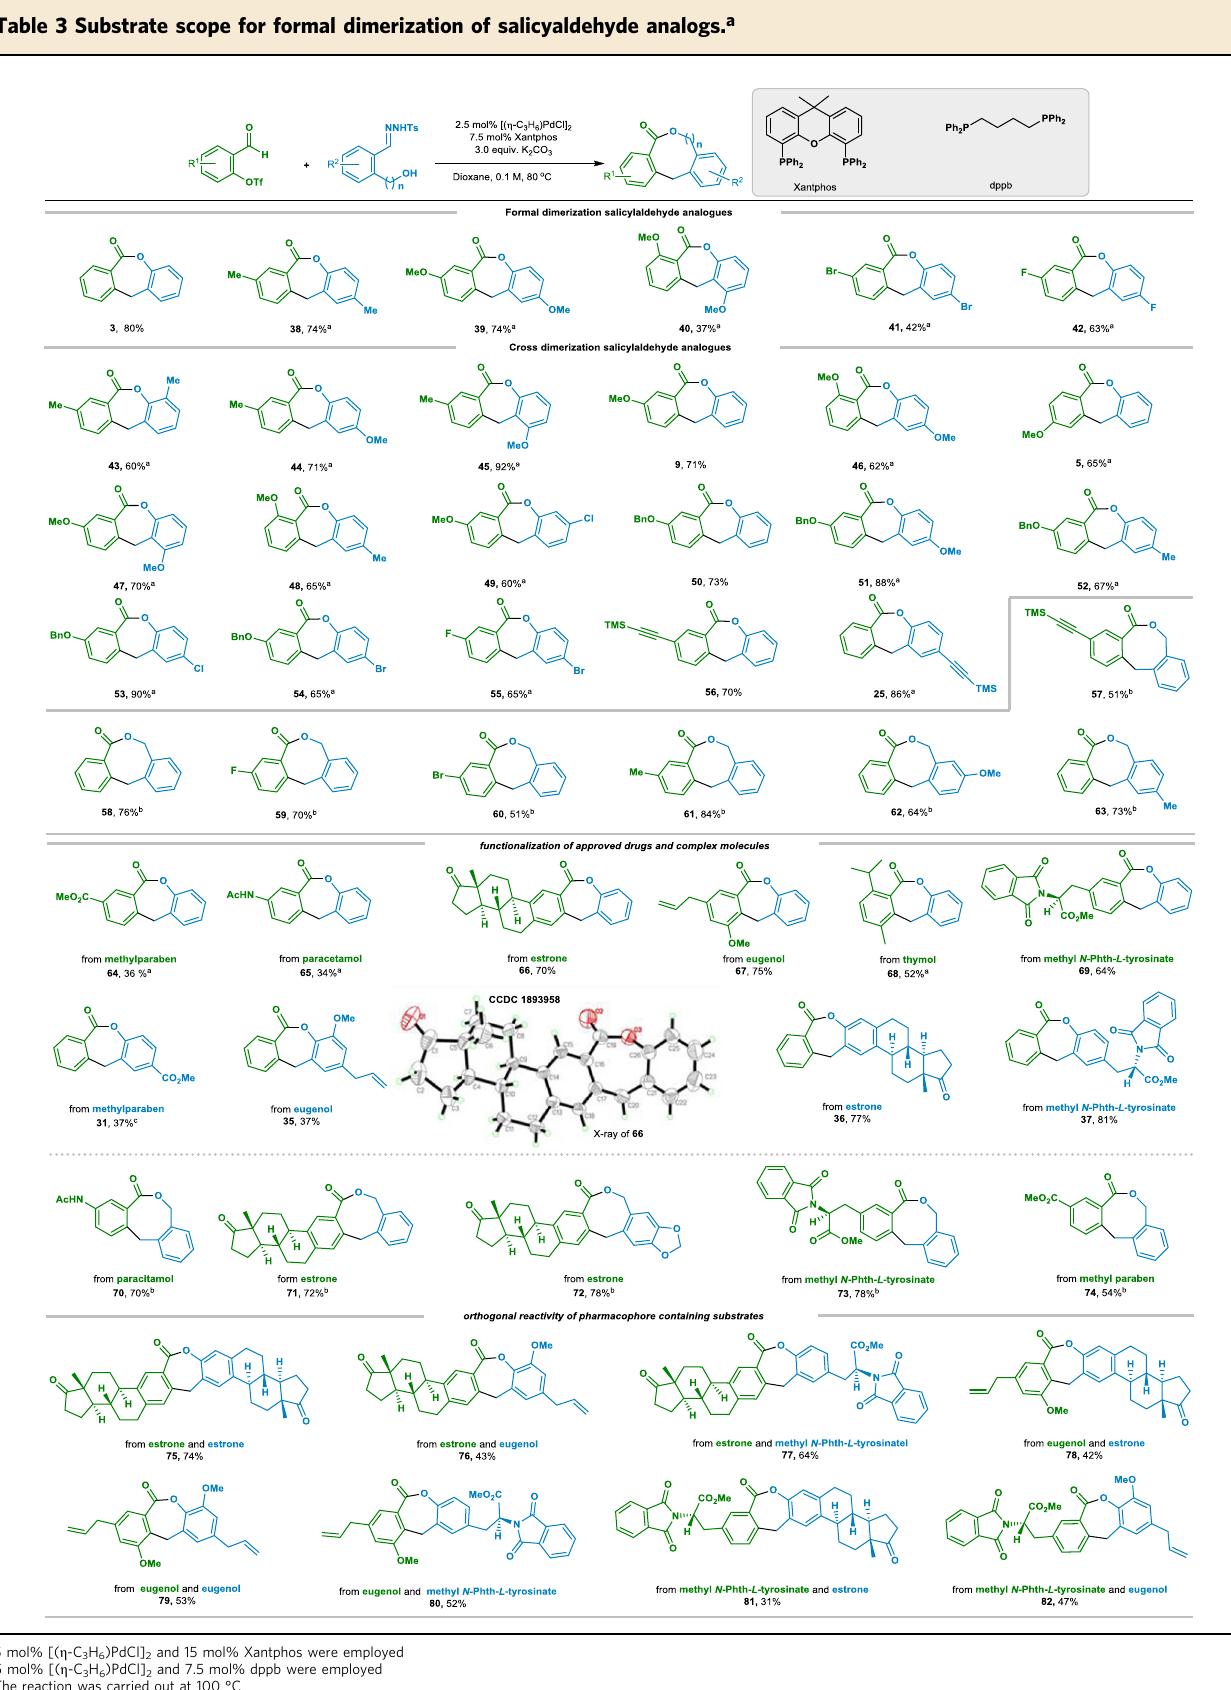
Table 3 Substrate scope for formal dimerization of salicyaldehyde analogs.